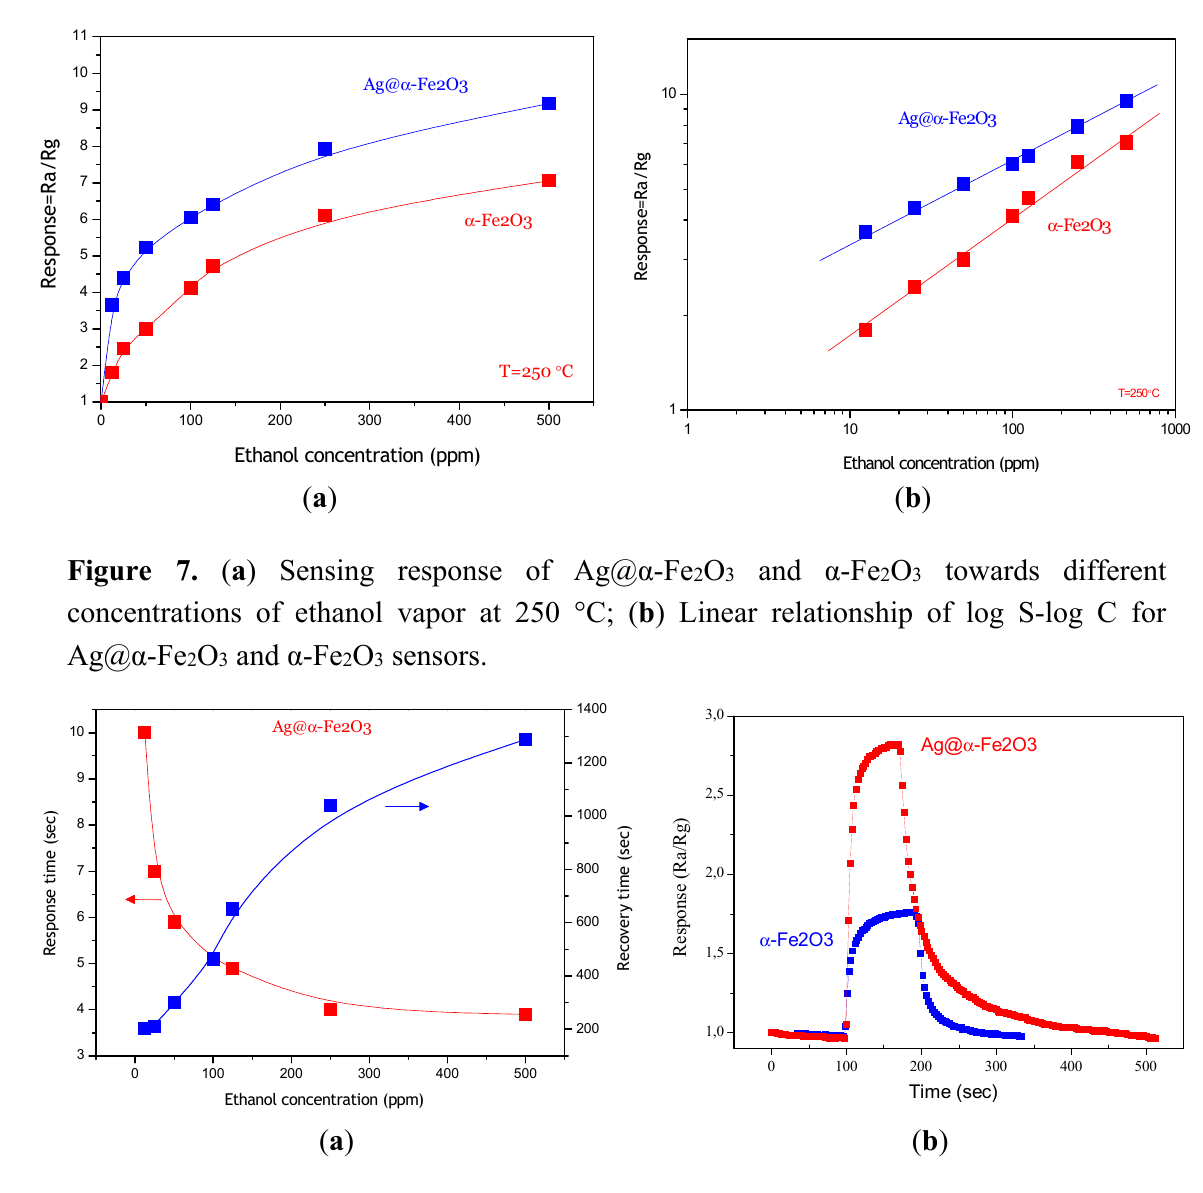
Figure 8. ( a ) Response and recovery times for Ag@ α -Fe 2 O 3 sensor; ( b ) Response of Ag@ α -Fe 2 O 3 and α -Fe 2 O 3 sensors towards 12.5 ppm ethanol at 250